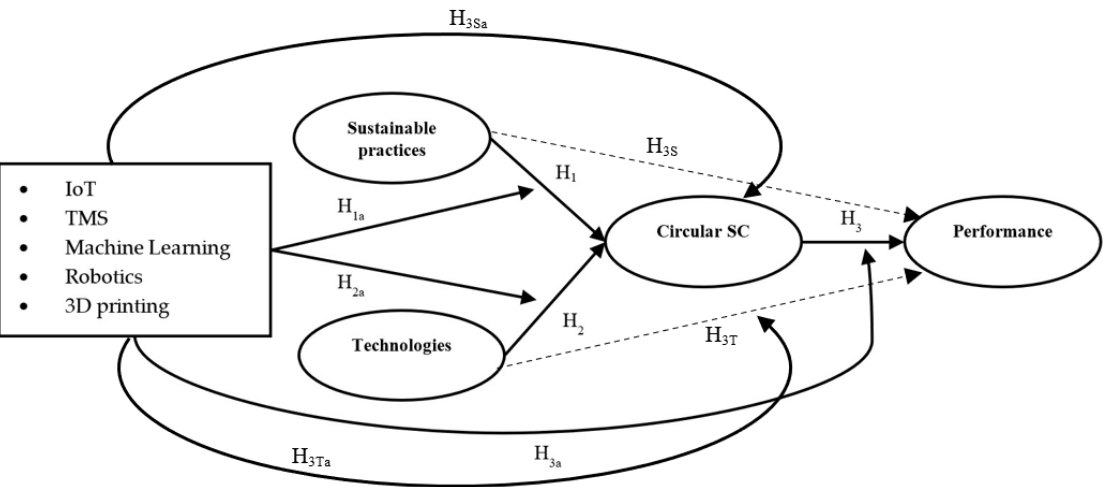
Figure 1. Conceptual